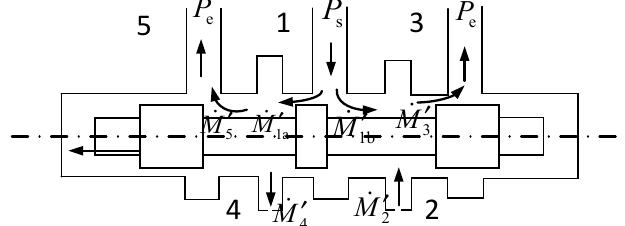
Figure 9. Directional control valve core Is moving in gas flow schematic.